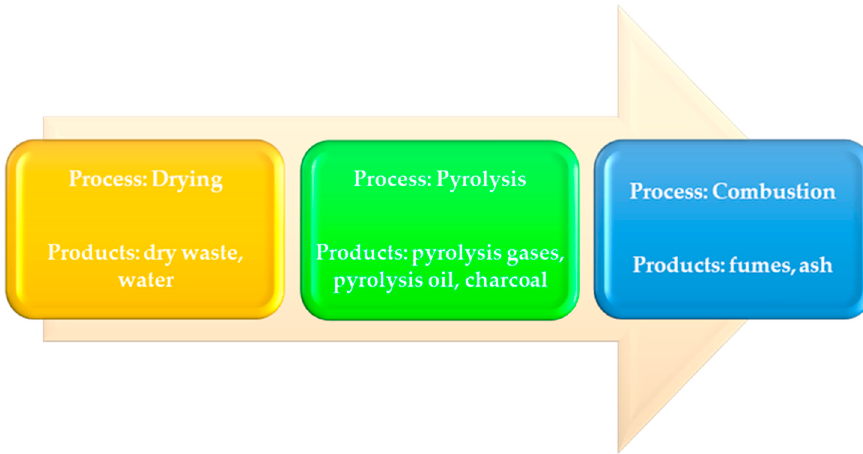
Figure 7. Diagram of thermal management of tannery waste.